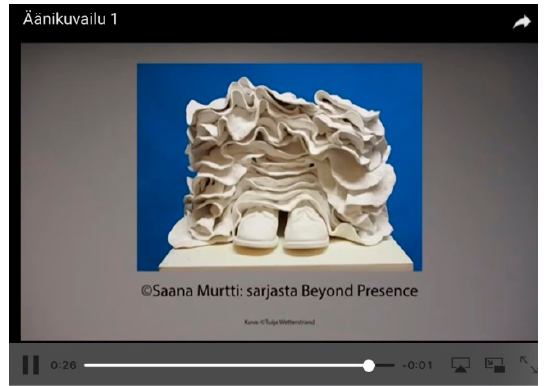
Figure 3. Sound description number 1 as it is presented on the website. Photo: The Finnish Deafblind Association Archive.